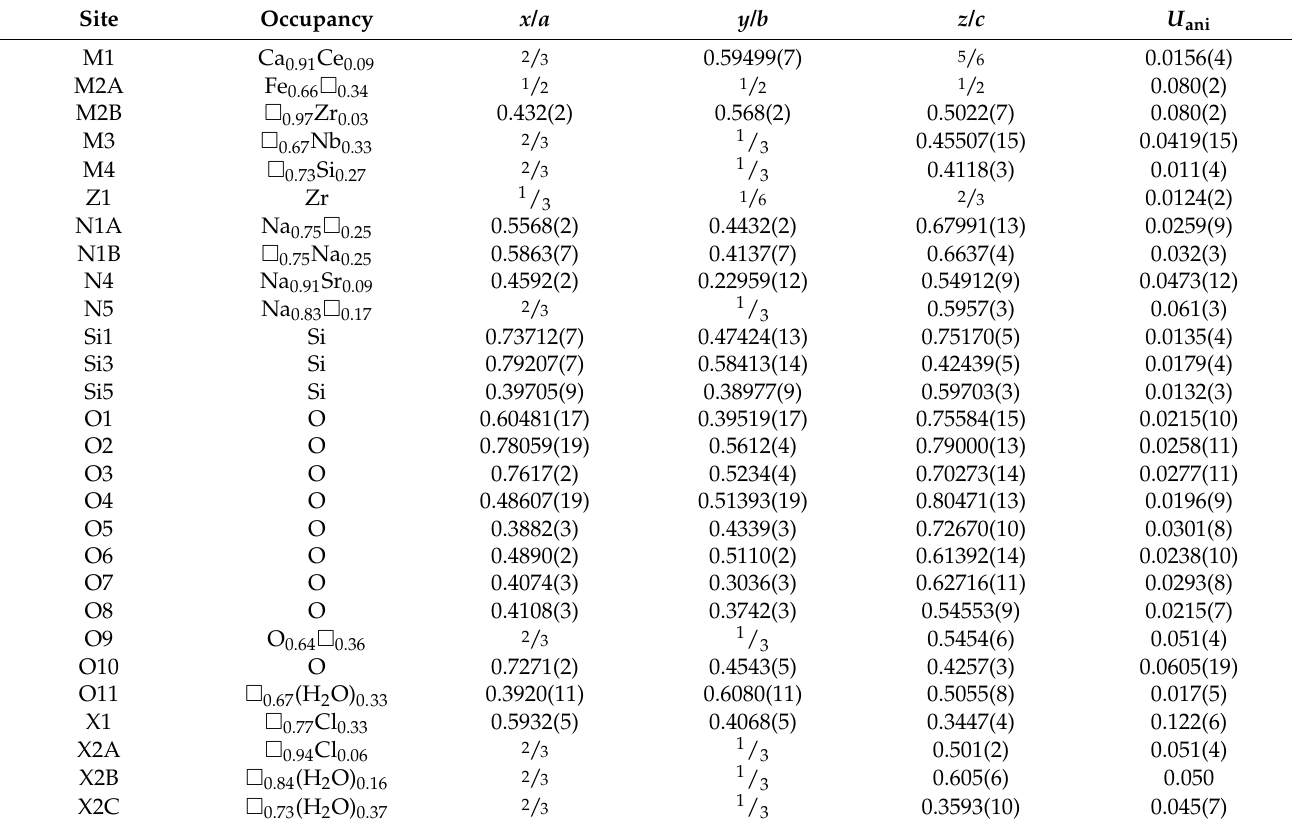
Table 3. Atomic coordinates, occupancies and equivalent isotropic displacement parameters LV-153/178 EGM